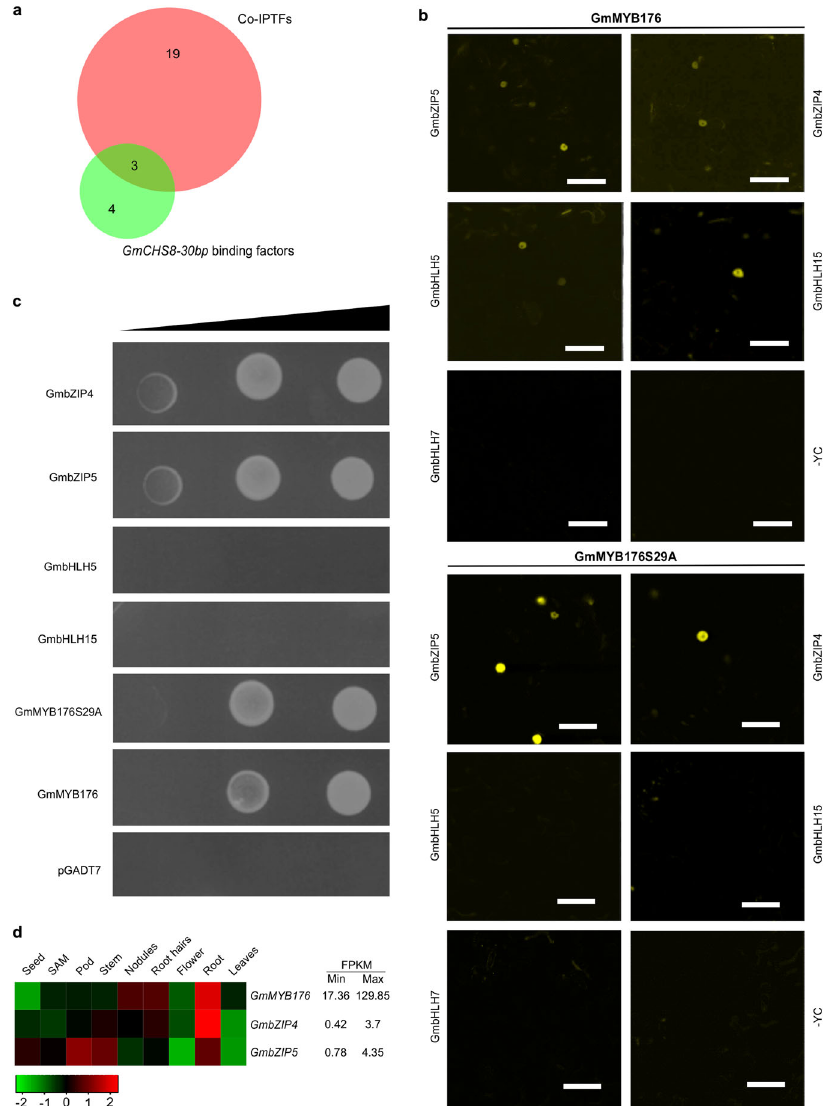
Fig. 2 GmMYB176-interacting transcription factors and their DNA binding activity. a GmMYB176- transcription factors obtained by co-IP assay GO annotation “ Biological process ” was retrieved and compared with the list of transcription factors obtained from in silico analysis of 30 bp GmCHS8